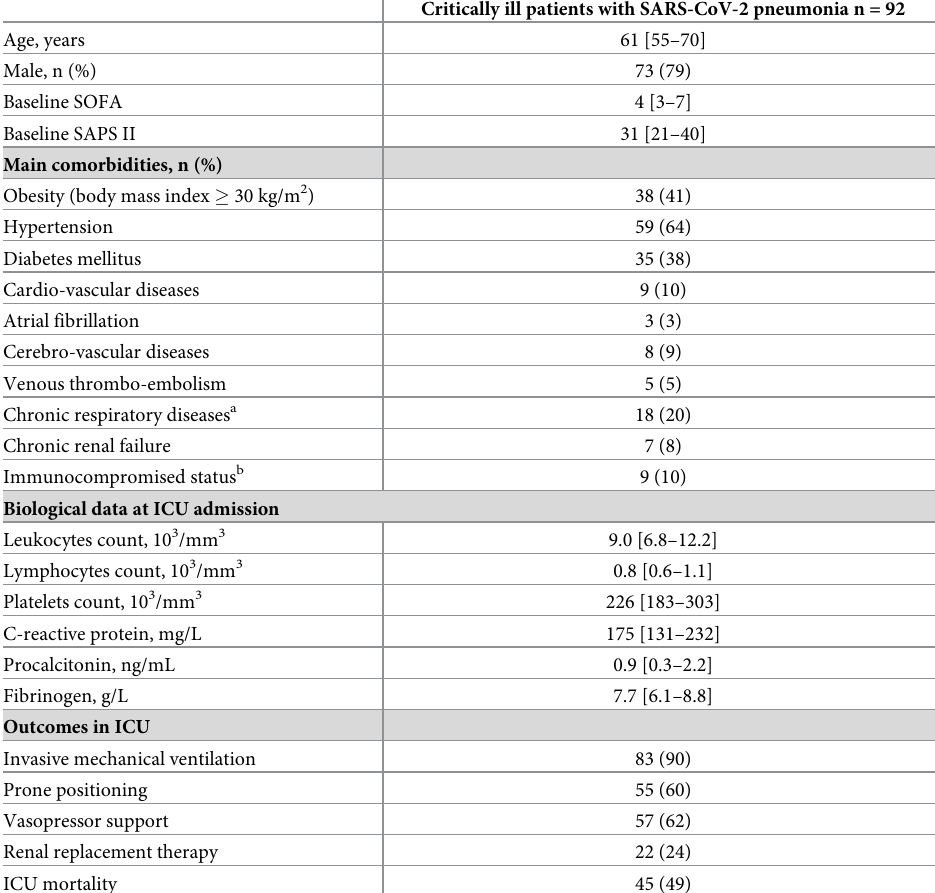
Table 1. Main characteristics, comorbidities, biological data and outcomes of the 92 COVID-19 patients admitted to our ICU.